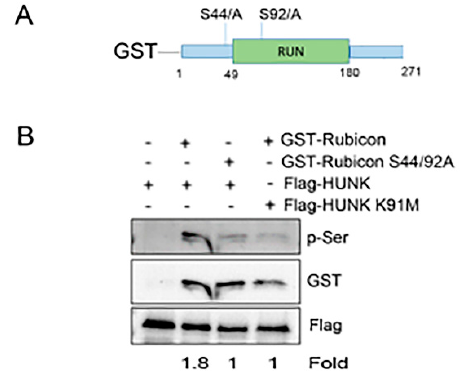
Figure 4. HUNK phosphorylates the N-terminal region of Rubicon. ( A ) GST-Rubicon containing amino acids 1-271 with S44 and S92 mutated to alanine ( B ) In vitro kinase assay using Flag-WT HUNK and Flag-K91M HUNK as kinase and GST-Rubicon or GST-Rubicon S44 / 92A as substrate. Reactions were immunoblotted for p-Ser to detect Rubicon phosphorylation and GST or Flag to confirm the presence of HUNK and Rubicon in each reaction.